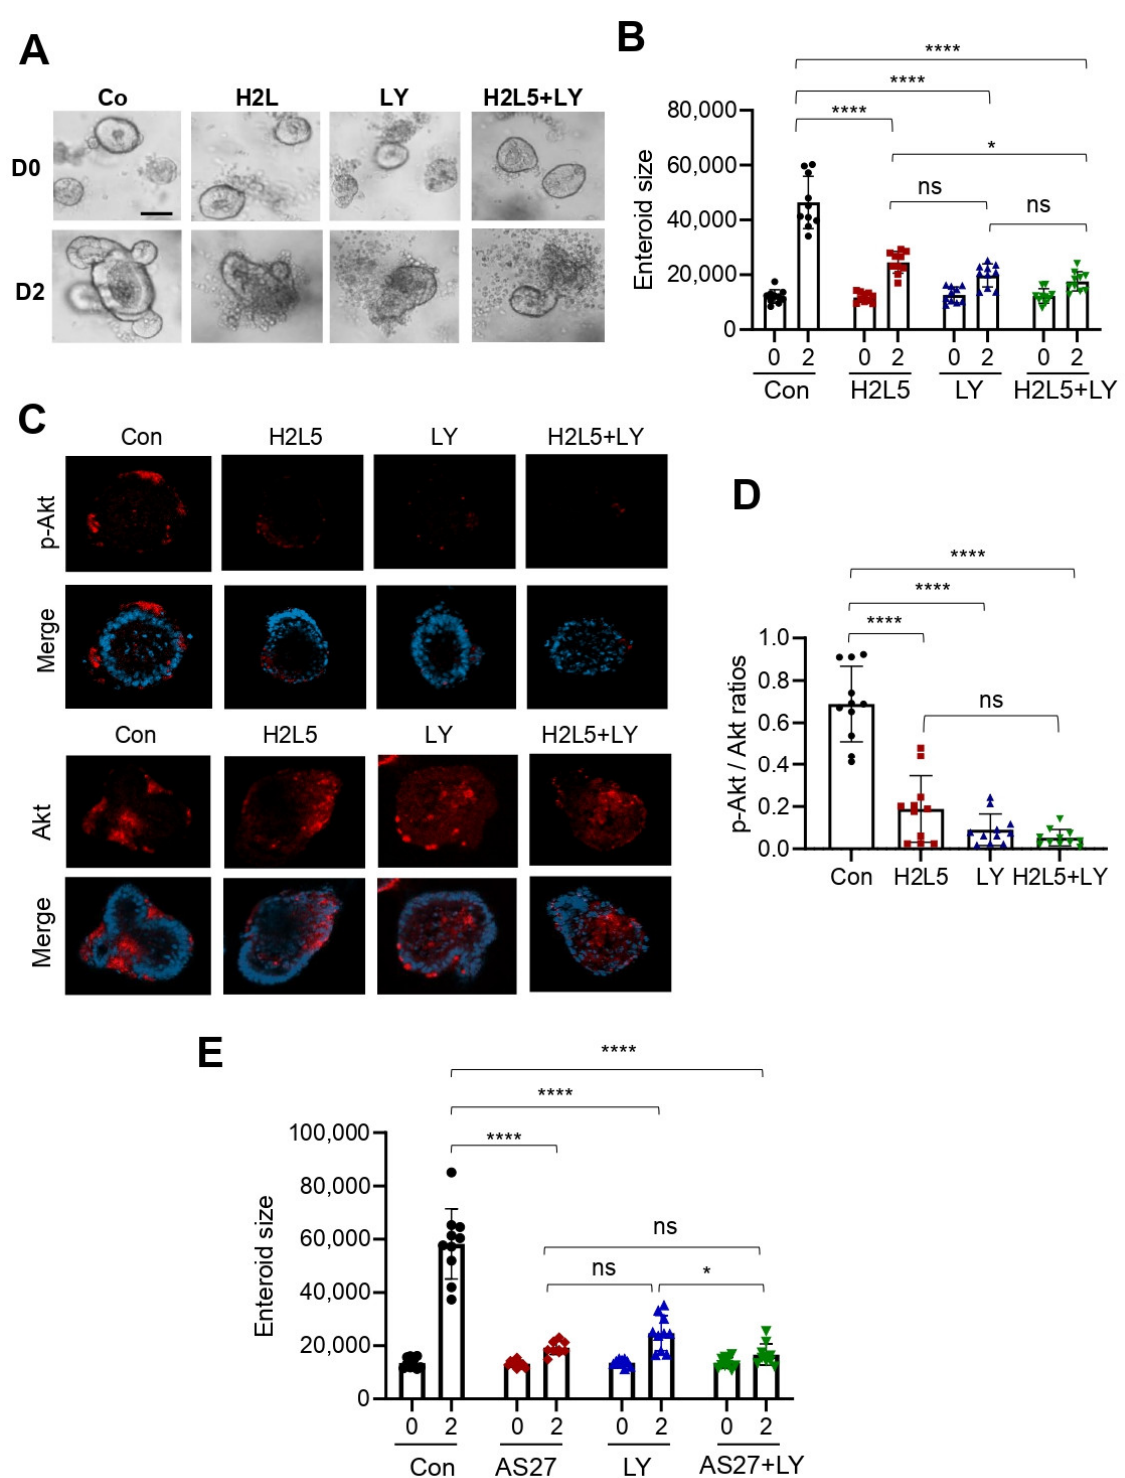
(lower panel) are shown. Bar = 50 μm. **** p < 0.000, and ns = not significant by two-way ANOVA with Tukey’s multiple comparison test.